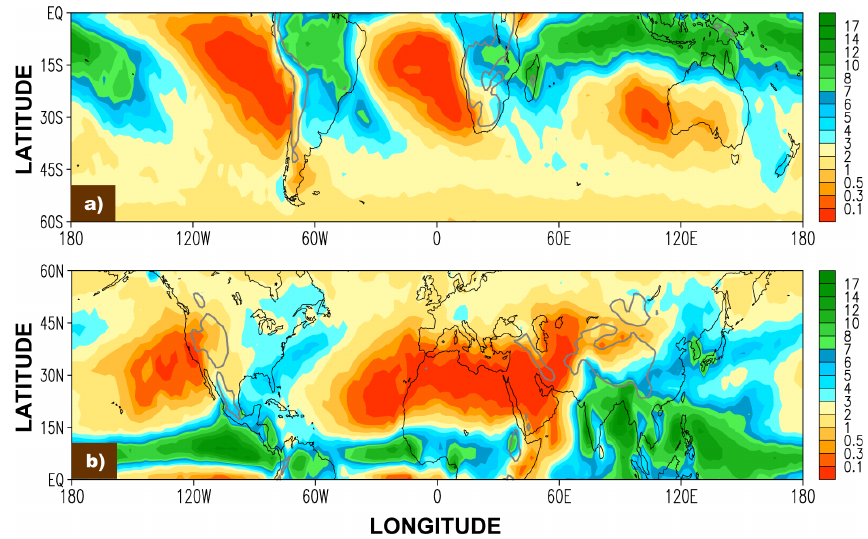
Fig. 12. Distributions of monthly mean rainfall (mmd − 1 ) averaged over the period 1980–1997 for (a) January and (b) July, and grey lines indicate topography with an elevation of 1000m in (a) and 1500m in